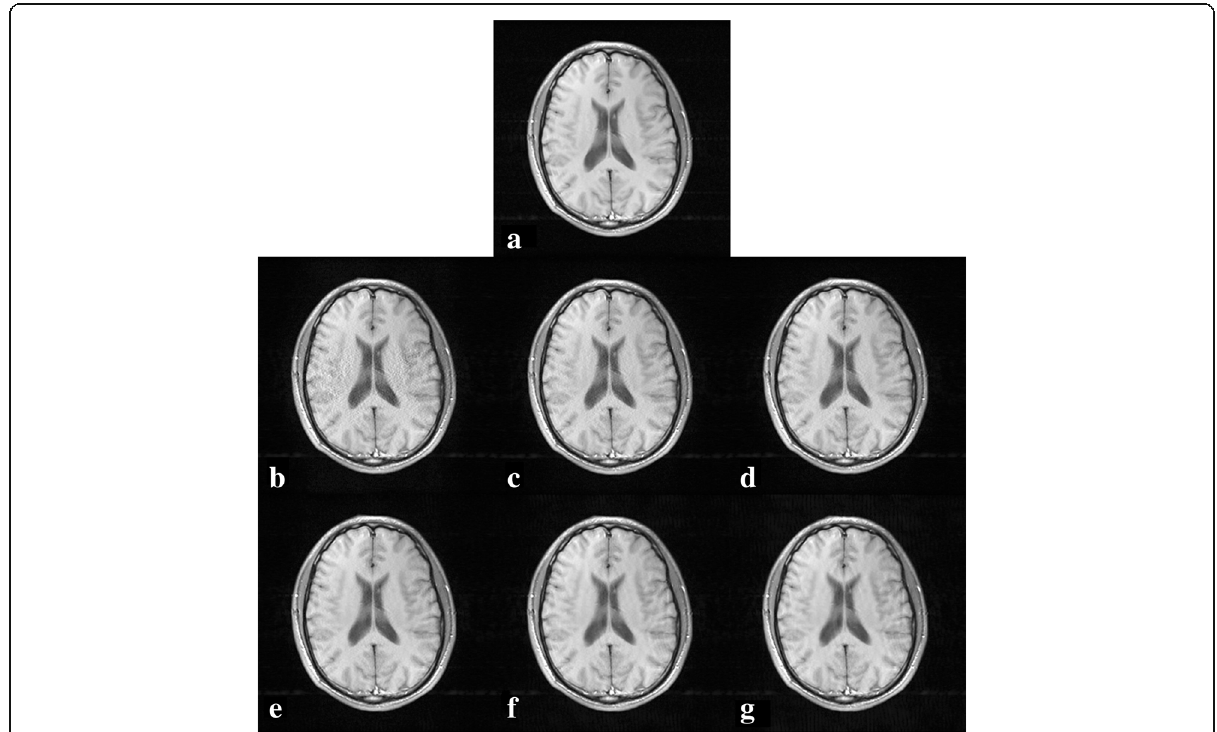
Fig. 5 Brain images reconstructed with different number of the second-order terms from the same data set in Fig. 3. a A reference image with SoS reconstruction of fully sampled data. b – g Reconstructed images using AV-GRAPPA with different numbers of the second-order terms. They are 1 time, 3 times, 5 times, 11 times, 17 times, and 21 times of the number of the original linear terms. When the less number of the second-order terms is used, noise cannot be suppressed completely. On the other hand, when the more number of the second-order terms is used, noise is removed but aliasing artifacts are appearing. Therefore, the number in the middle range can help produce high-quality reconstructed